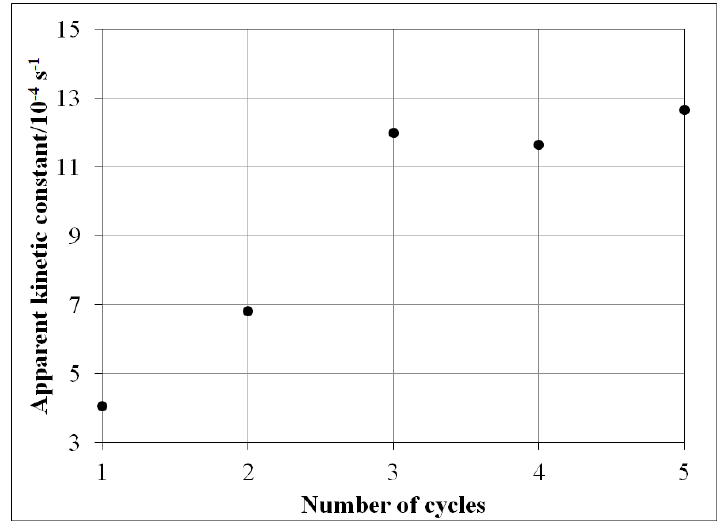
Figure 16. The effect of the reuse of Cu II O/Fe II O/Fe III 2 O 3 composite catalyst on the apparent kinetic constant of MB. Experimental conditions: concentration of composite = 400 mg/L, concentration of MB = 1.5 × 10 −5 mol/L, concentration of H 2 O 2 = 1.76 × 10 −1 mol/L, pH = 7.5, and irradiation time = 140 min (each cycle).